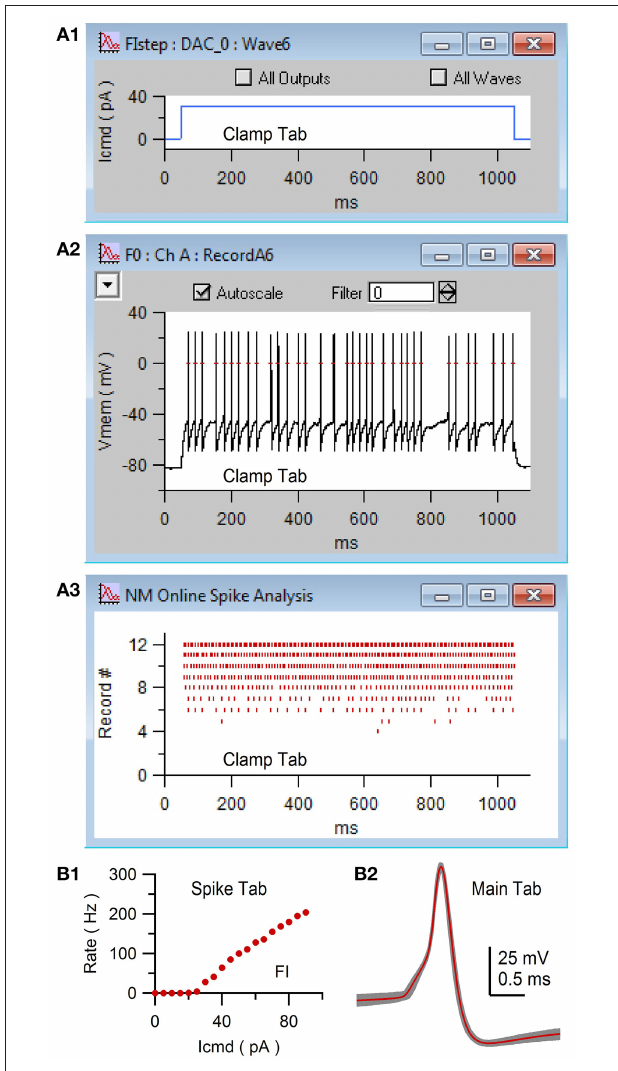
FIGURE 7 | Acquisition of whole-cell current-clamp data with online spike detection via NeuroMatic’s Clamp tab. Clamp tab acquisition of the membrane potential (V mem ) of a GC. The stimulus protocol was called FIstep (see Figure 6 ) consisting of 20 consecutive step current commands (I cmd ) with increasing amplitude ( + 5pA). (A1) Plot of the seventh I cmd (DAC wave #6) consisting of a 1s step to 30pA. The plot was created via the Clamp/Stim/Pulse/Plot button. (A2) Channel graph display of V mem in response to I cmd in (A1) . Red dashes denote action potentials detected by NeuroMatic’s online spike detector (threshold = 0mV), activated via the “spike” checkbox on the Clamp/Stim/Misc tab. (A3) Spike raster plot of NeuroMatic’s online spike detector for recordings #0–12. (B1) Spike-tab analysis after acquisition. Spike rate versus I cmd (FI relation) computed via the “Avg Rate” button. (B2) Detected spikes were copied to new waves with prefix “Spike0” via the “Spikes 2 Waves” button on the Spike tab. Shown here are the copied spikes overlaid (gray; n = 268) and their average (red) computed via the Main tab. Experimental details: cerebellar slice from a P35 rat, R a = 17.5 M (cid:127) , C mem = 2.4 pF.